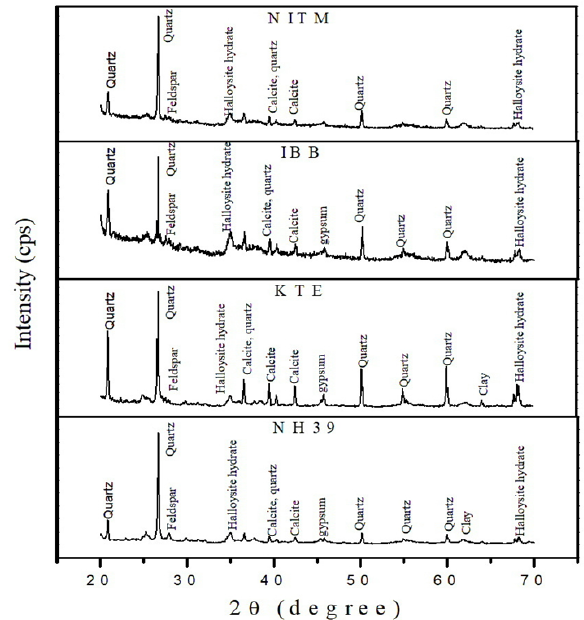
Figure 8. XRD analysis of Northeast Indian peats.